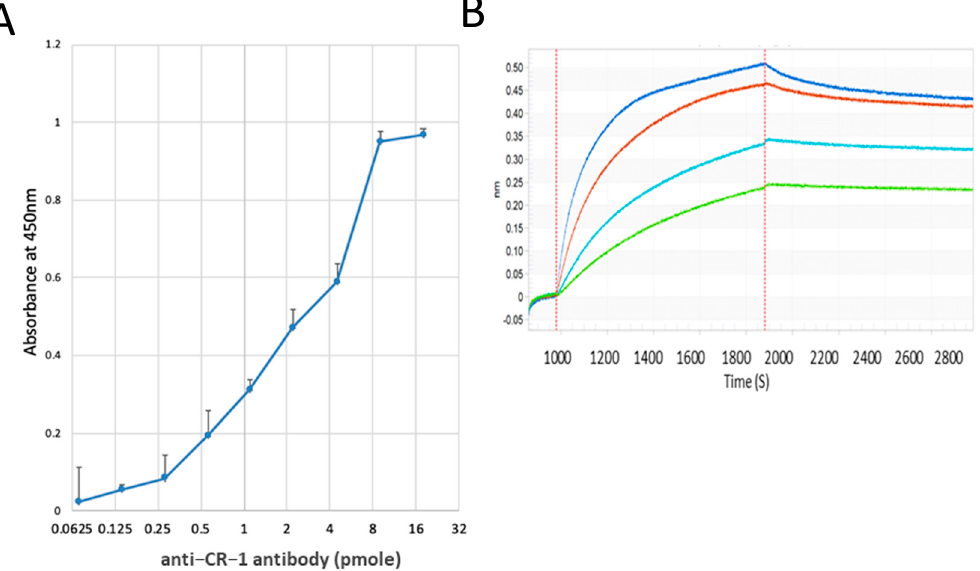
Figure 5. Affinity of anti-CR-1 antibody Clone 35 to antigen: ( A ) The binding ability of purified anti-CR-1 antibody to CR-1 was assessed by ELISA. Anti-CR-1 antibody in 0.68 mg/mL was sequentially diluted and applied into 96-well plate, which was fixed with rshCR-1. The bound antibody was detected with anti-human IgG labeled with HRP. Each plot was shown as mean ± SD from three independent experiments. ( B ) The global fitting curves demonstrating the affinity of anti-CR-1 Ab to rshCR-1 analyzed by BLI method. Each concentration of antibody is 25 nM (green), 50 nM (light blue), 100 nm (brown) and 200 nM (blue). Table 1. Affinity of anti-CR-1 antibody to rshCR-1 measured by OCTET system.